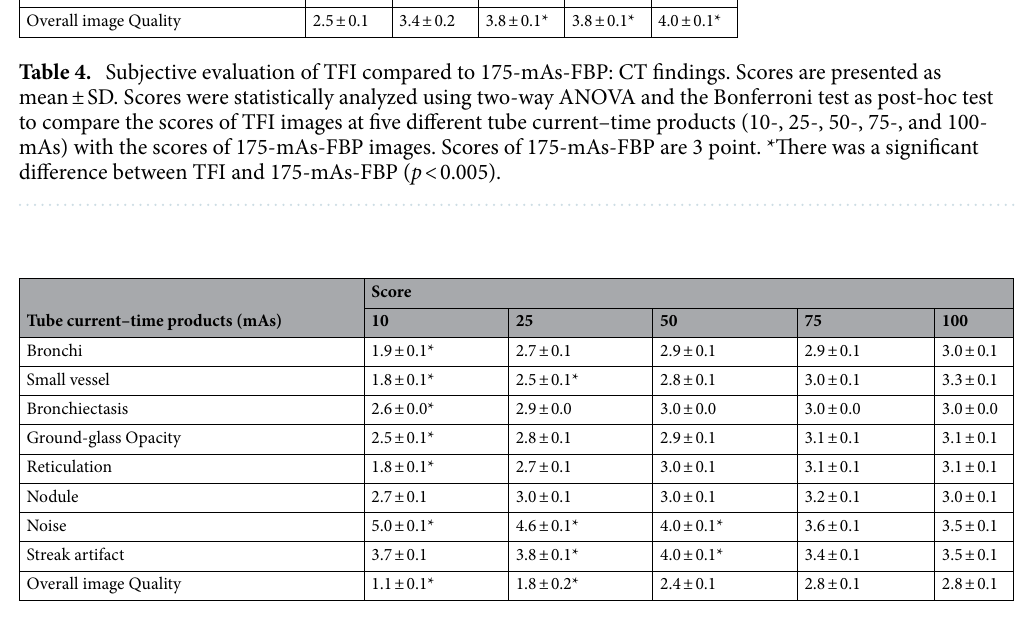
Table 5. Subjective evaluation of FBP compared to 175-mAs-FBP: CT findings. Scores are presented as mean ± SD. Scores were statistically analyzed using two-way ANOVA and the Bonferroni test as post-hoc test to compare the scores of FBP images at five different tube current–time products (10-, 25-, 50-, 75-, and 100- mAs) with the scores of 175-mAs-FBP images. Scores of 175-mAs-FBP are 3 points. *There was a significant difference between FBP and 175-mAs-FBP ( p <